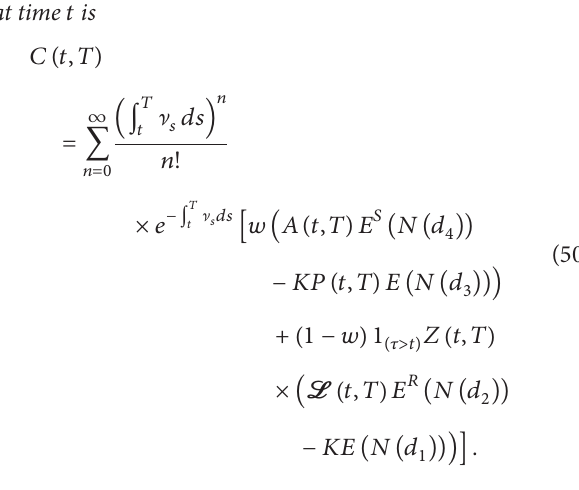
Figure 1: The option price with different recovery rate for 𝑇 = 1 , = 0.7 , 𝜌 = 0.5 , and 𝜌 = 0.6 . 𝜌 12 13 23